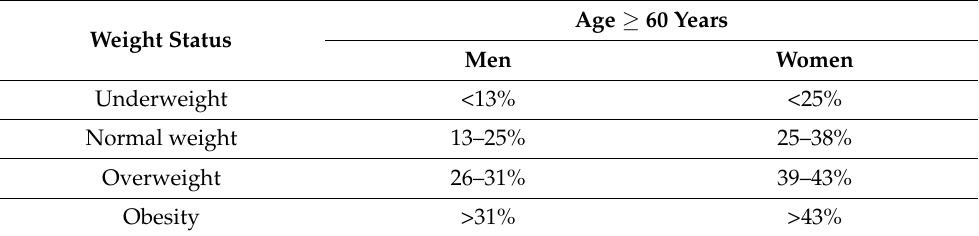
Table 1. Age- and sex-specific cut-offs for assessing weight status by body adiposity index